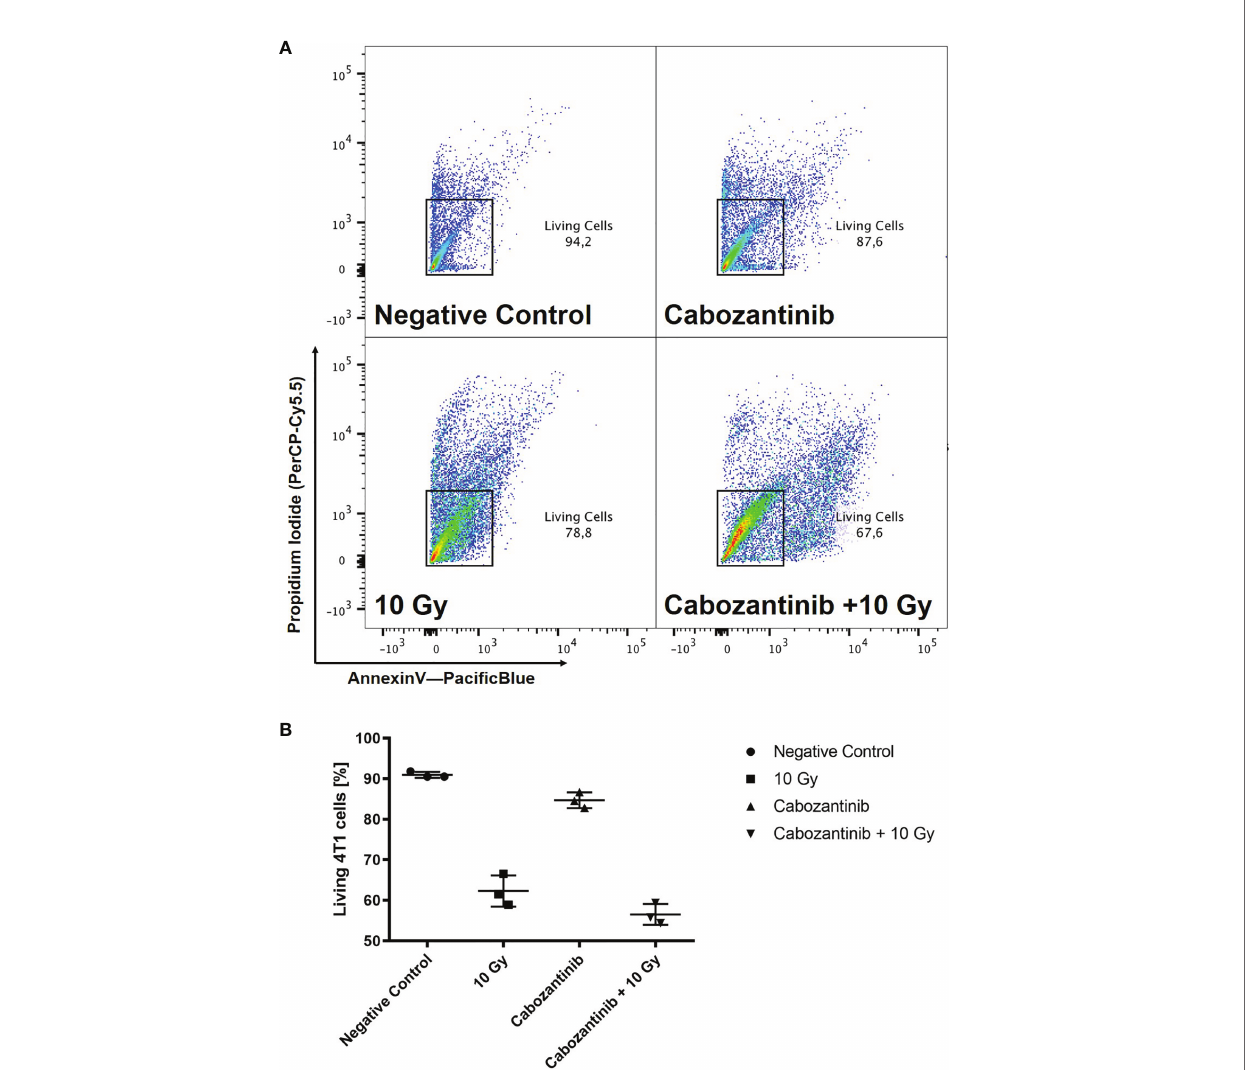
FIGURE 3 | Cell death after treatment with x-rays and Cabozantinib. Cell death was assessed as described following exposure to 10 Gy of x-rays, 2.5 µM Cabozantinib or both. Exemplary scatter plots resulting from fl ow cytometry analysis (A) . Cells positive for propidium iodide and Annexin-V were excluded to obtain living cells. The example is representative for the other biological replicates. Amount of living 4T1 cells 72h after treatments (B) . Results are derived from three independent experiments (mean value ± SD). A One-way ANOVA revealed signi fi cant differences for 10 Gy and Cabozantinib + 10 Gy as compared to the negative control (p<0.0001), but not for Cabozantinib alone (p=0.0653) or between 10 Gy and Cabozantinib + 10 Gy